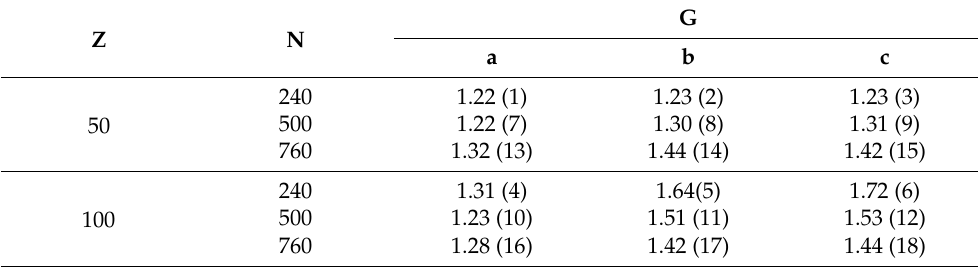
Table 1. Overview of DRUDIT runs for parameter tuning. Absolute deviation from true values (|DTV(GI 50 )|) is reported, and run codes (1–18) are given in